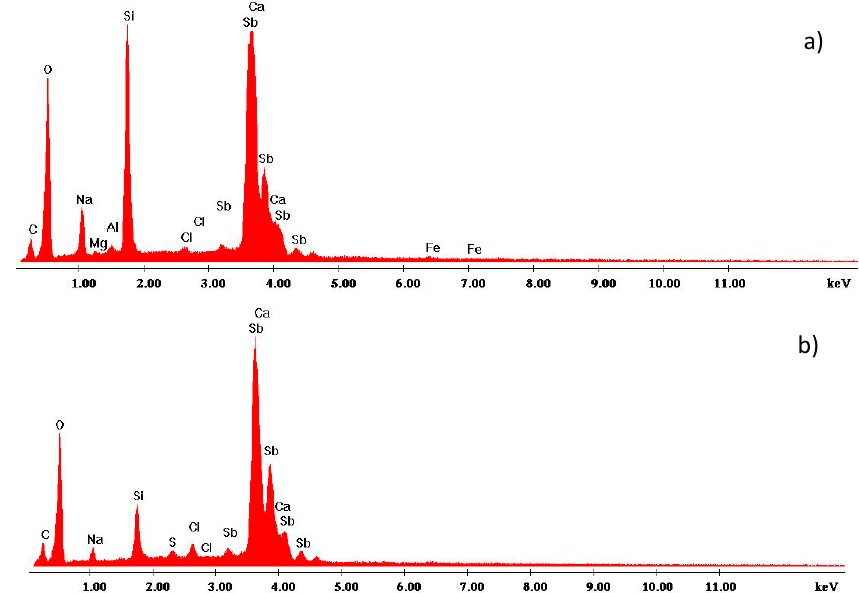
Figure 3. ( a – b ) BSE images of micrometric crystals with euhedral habit, found either in clusters or isolated in SSV_W1 white and SSV_B1 blue natron-based tesserae (monastic complex of San Severo in Classe, Ravenna, Italy - unpublished data); ( c – d ) sub-micrometric euhedral crystals compactly arranged together in a circular conformation (rosary-shaped cluster).